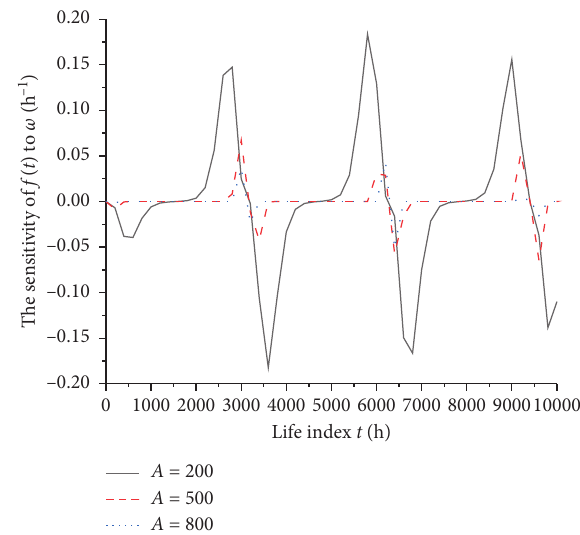
Figure 31: The sensitivity of f ( t ) to 2 ω ( A �